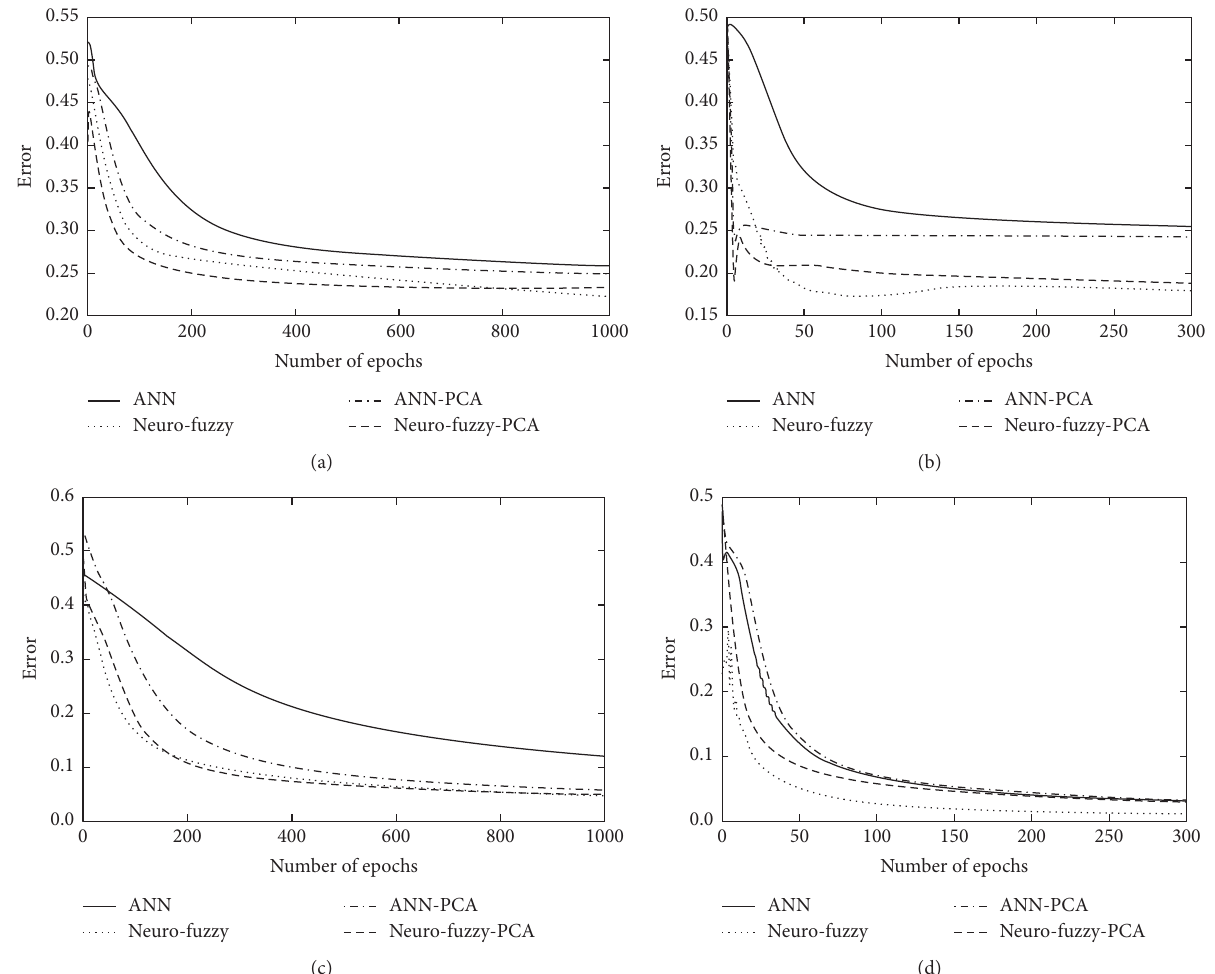
Figure 5: Error plots of four datasets: (a) Titanic; (b) Mammographic; (c) Breast Cancer; (d) Wine. Table 2: Comparison of classification accuracy of ANN, NF, ANN-FR, and NF-FR.